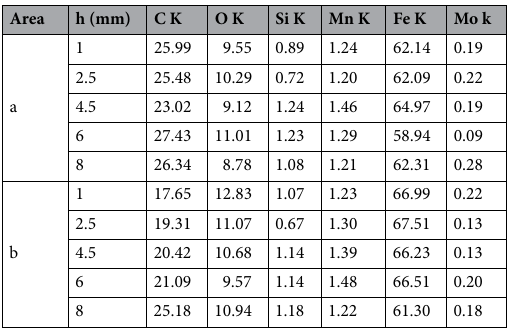
Table 3. EDS test element content inside and outside defect of defect samples under static liquid film (atom %).